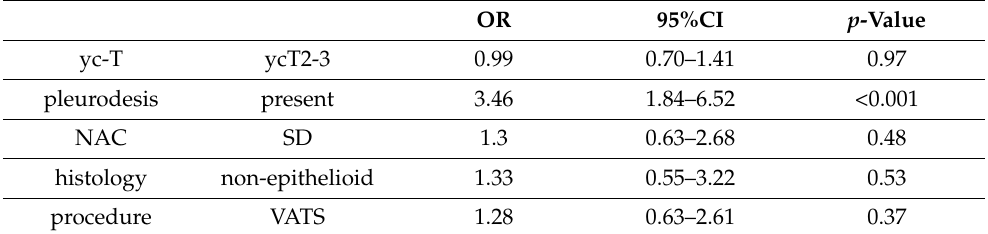
Table 4. Multivariate analyses between p-CWM and clinical